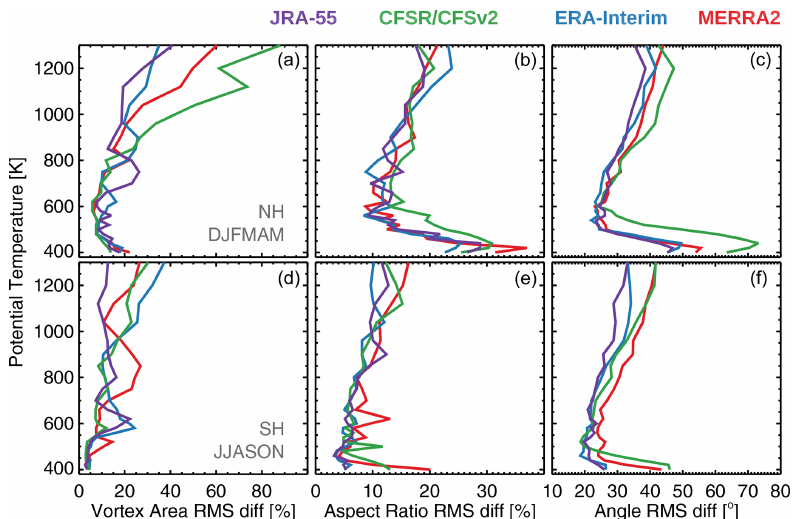
Figure A5. Root-mean-square (RMS) daily (1980–2014) differences. (a, d) RMS vortex area difference, (b, e) RMS aspect ratio difference, (c, f) RMS equivalent ellipse angle